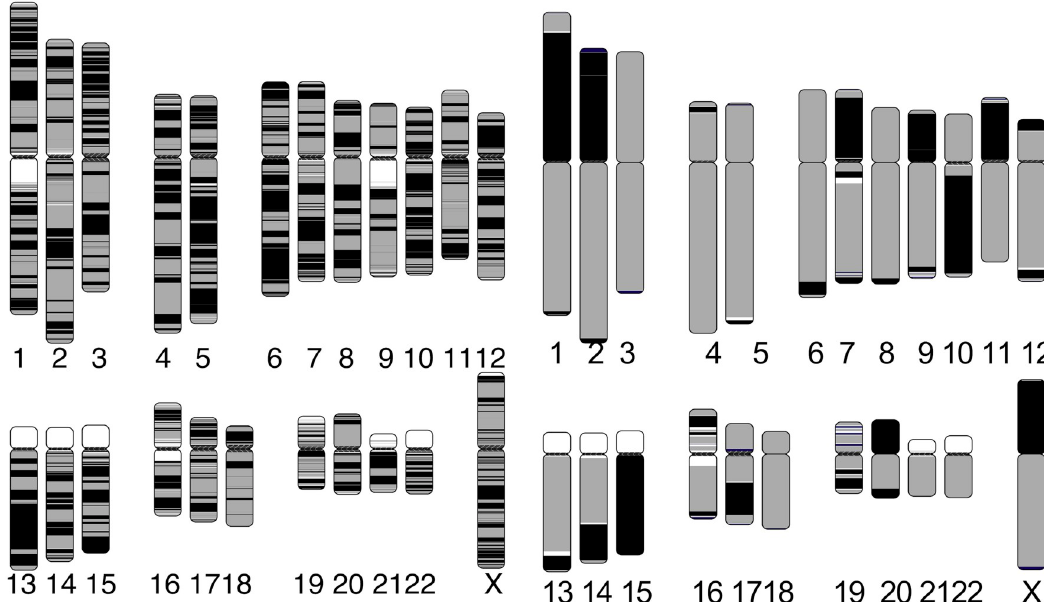
Fig 6. Chromosome ideogram generated using the coloredChromosomes [39] package. Each color switch denotes a change in the aligned sequence, either due to large structural error or the end of a contig/scaffold. Left: input contigs aligned to the GRCh38 reference genome. Right: SALSA2 scaffolds aligned to the GRCh38 reference genome. More than ten chromosomes are in a single scaffold. Chromosomes 16 and 19 are more fragmented due to scaffolding errors that break the alignment.